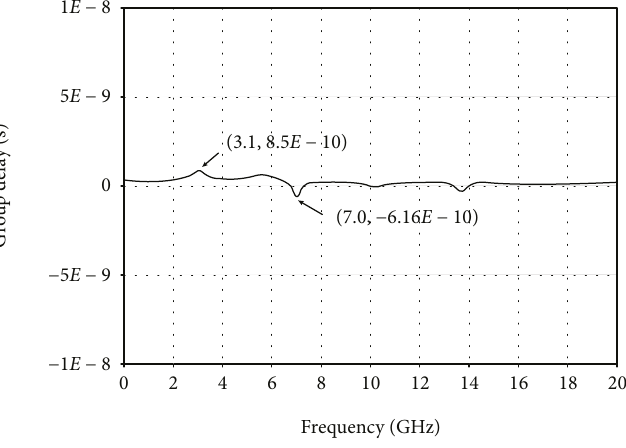
Figure 8: Simulated group